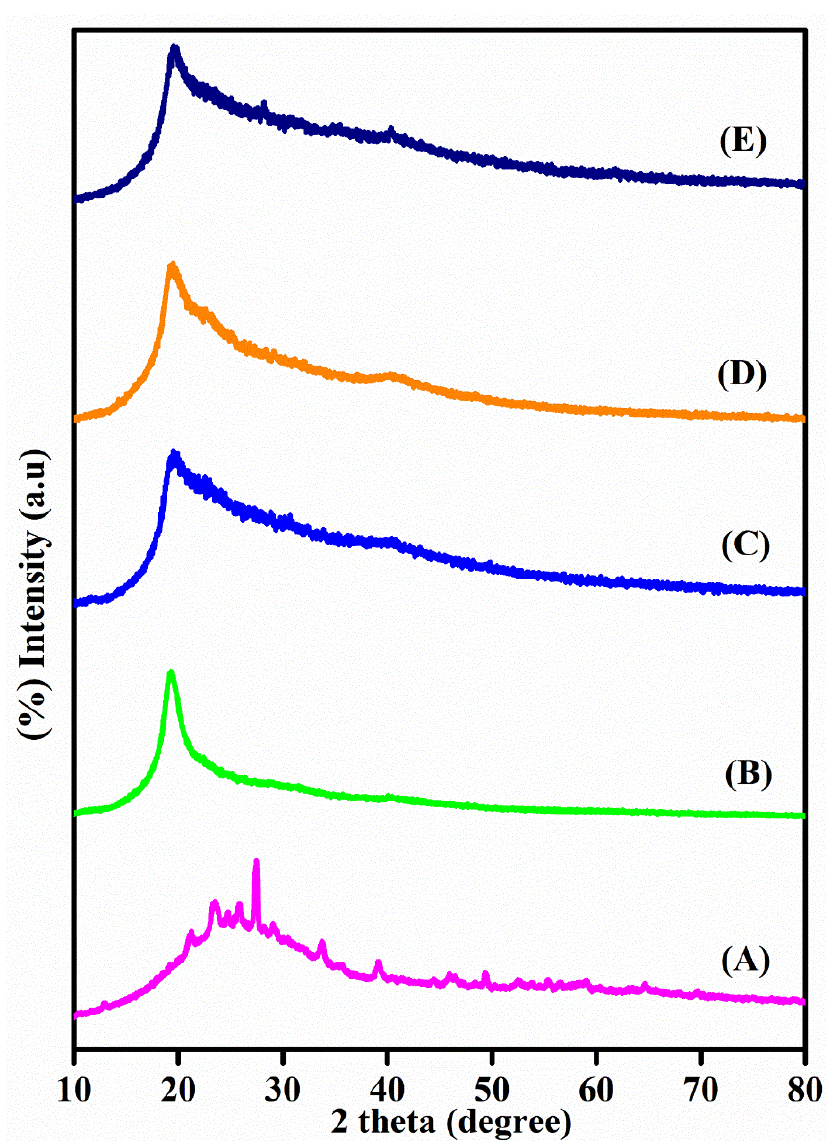
Figure 2. XRD patterns of phosphomolybdic acid ( A ) PSAAM ( B ), PSASB ( C ), PSAAM-PMA ( D ) and PSASB-PMA ( E ).